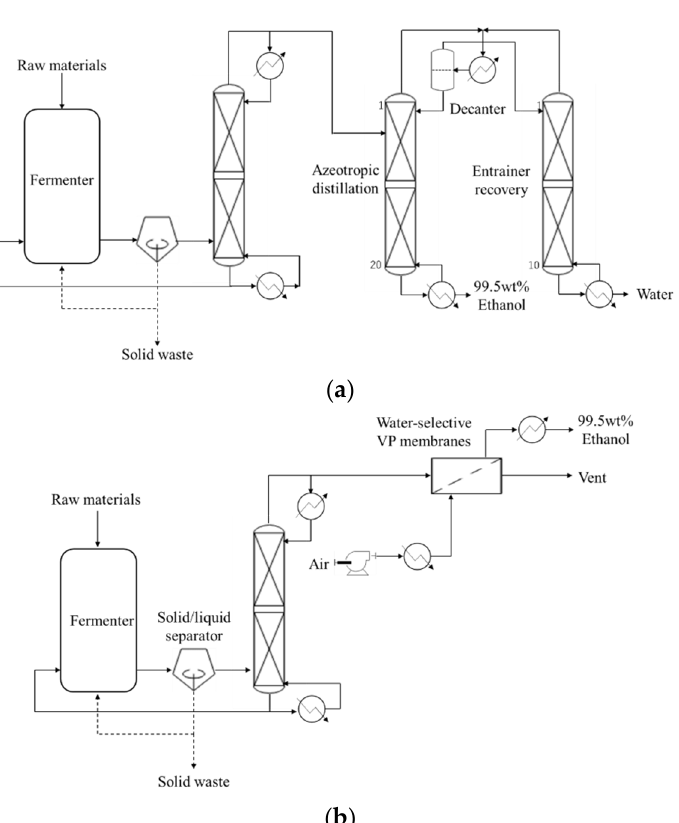
Figure 6. Distillation and dehydration membrane combined process: ( a ), diagram of distillation followed by azeotropic distillation; ( b ), diagram of distillation and membrane dehydration with sweep system combined.